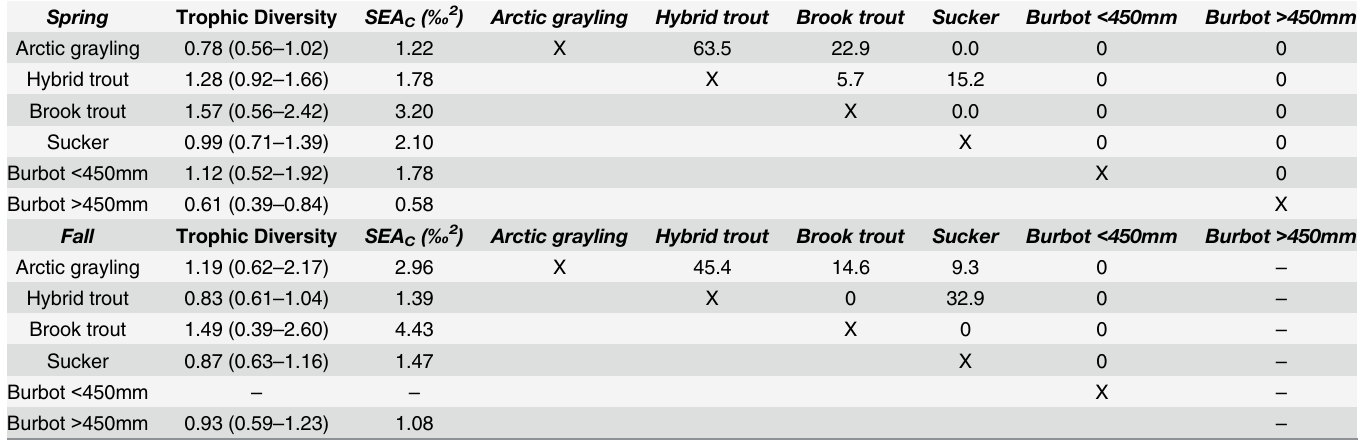
Table 2. Trophic diversity for fish taxa (median values along with 95% confidence interval ’ s derived from bootstrapping), small sample size-cor- rected standard ellipse areas (SEA c ), and comparison in SEA c overlap between pairs of species (as % of isotope niche space) for spring (top matrix) and fall (bottom matrix). ‘ − ‘ signifies no data. Trophic diversity values derived from Layman (2007,